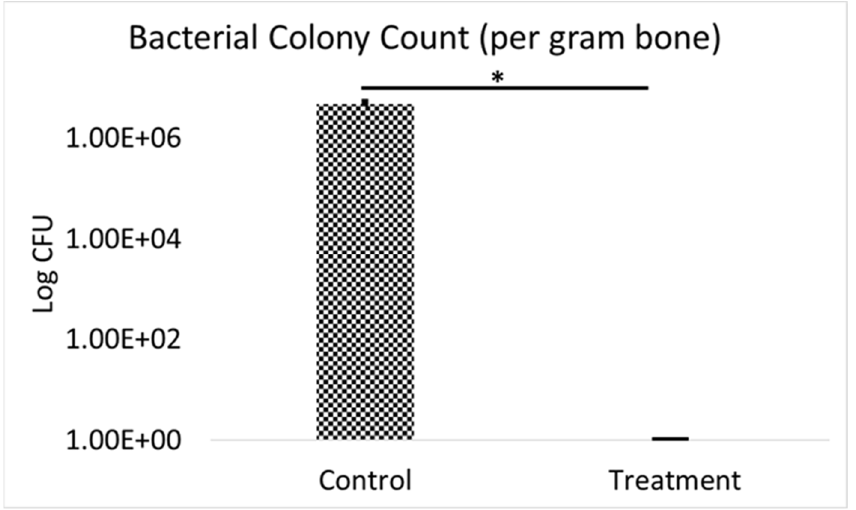
Figure 12. A high amount of bacterial presence was seen in infection control group rat tibiae. The treatment group rat bones showed no bacterial colony in culture. * p < 0.002.